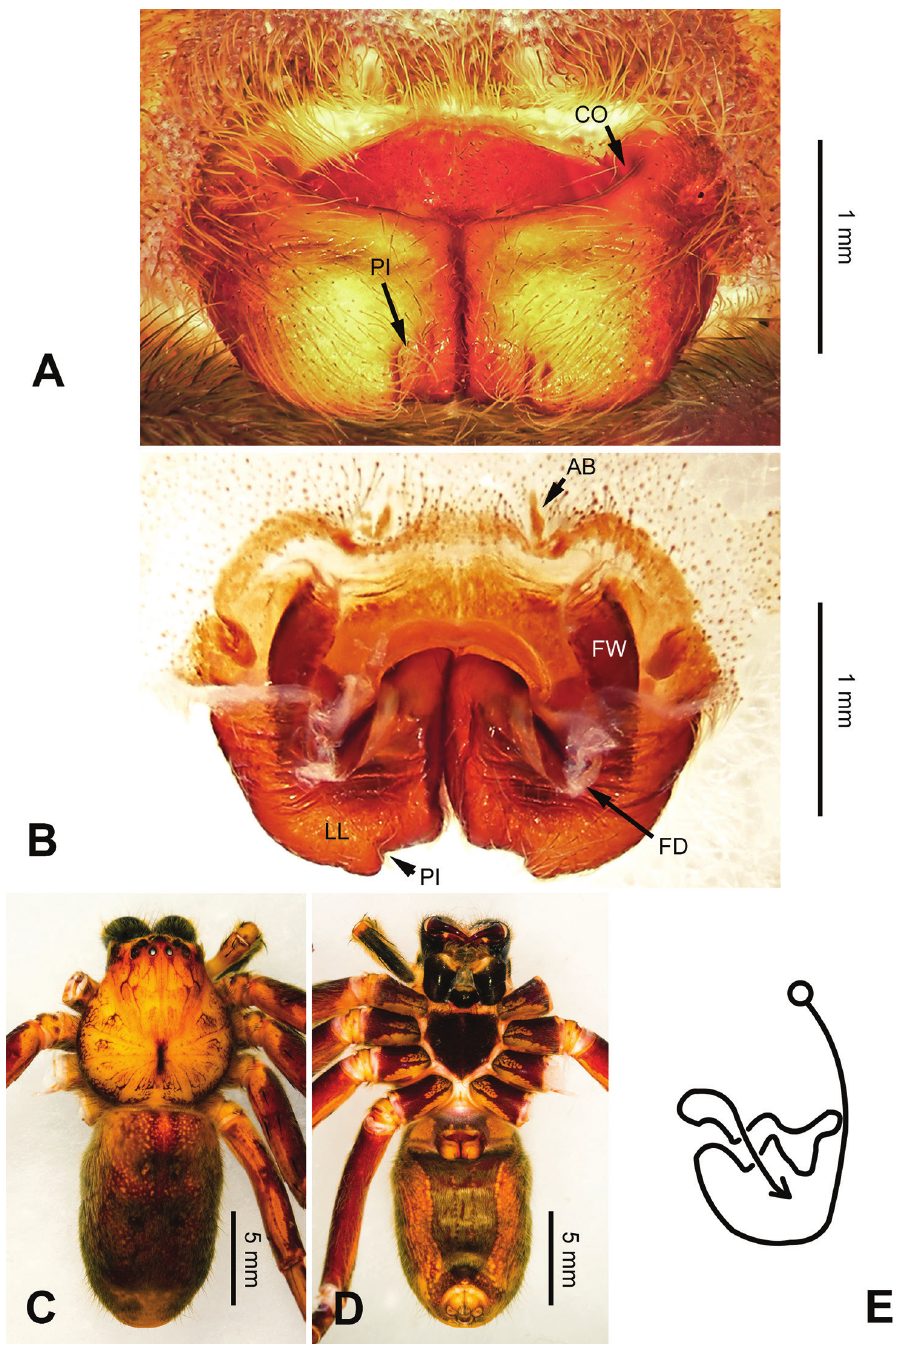
Figure 30. Pseudopoda titan Zhao & Li, sp. n., paratype female. A Epigyne, ventral view B Vulva, dorsal view C Habitus, dorsal view D Habitus, ventral view E Schematic course of internal duct system, dorsal